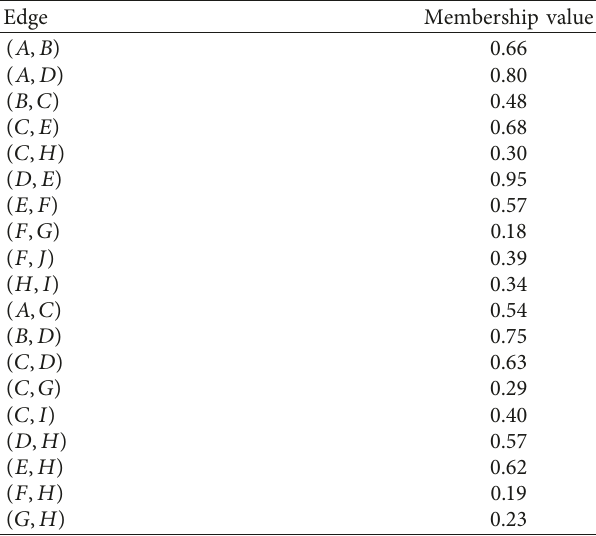
Figure 2: A generalized fuzzy graph. Table 5: Vertex membership value of Figure 2. Table 6: Edges membership value of Figure 2.